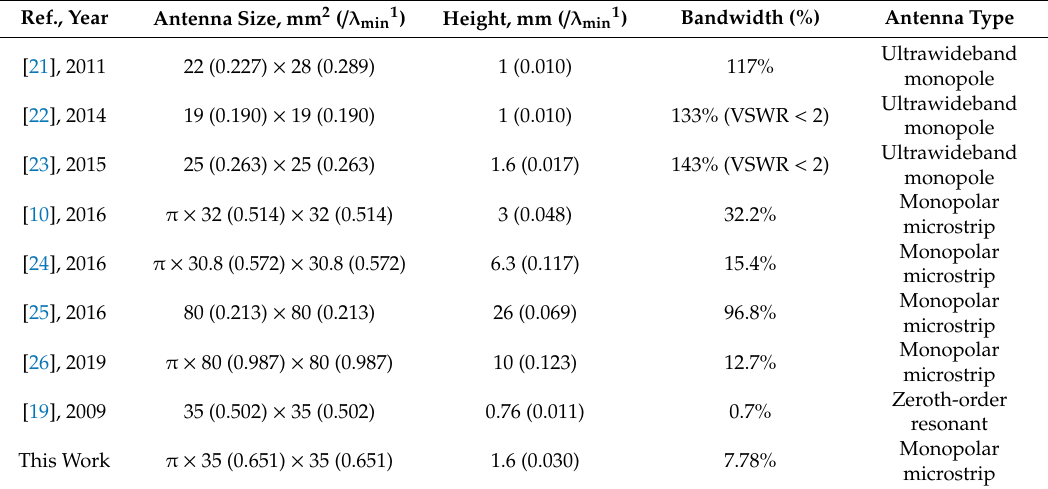
Table 2. Performance comparisons between state-of-the-art omnidirectional microstrip antennas. Ref.,